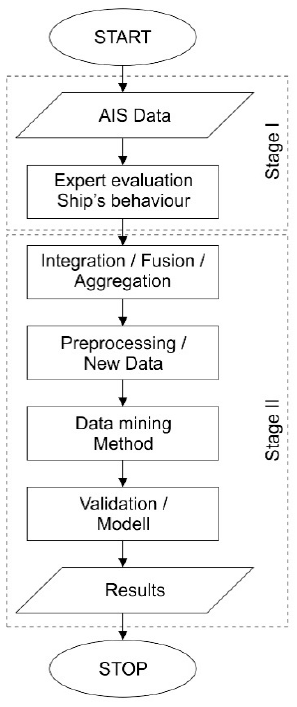
Figure 2. The process of navigator’s profile identification.